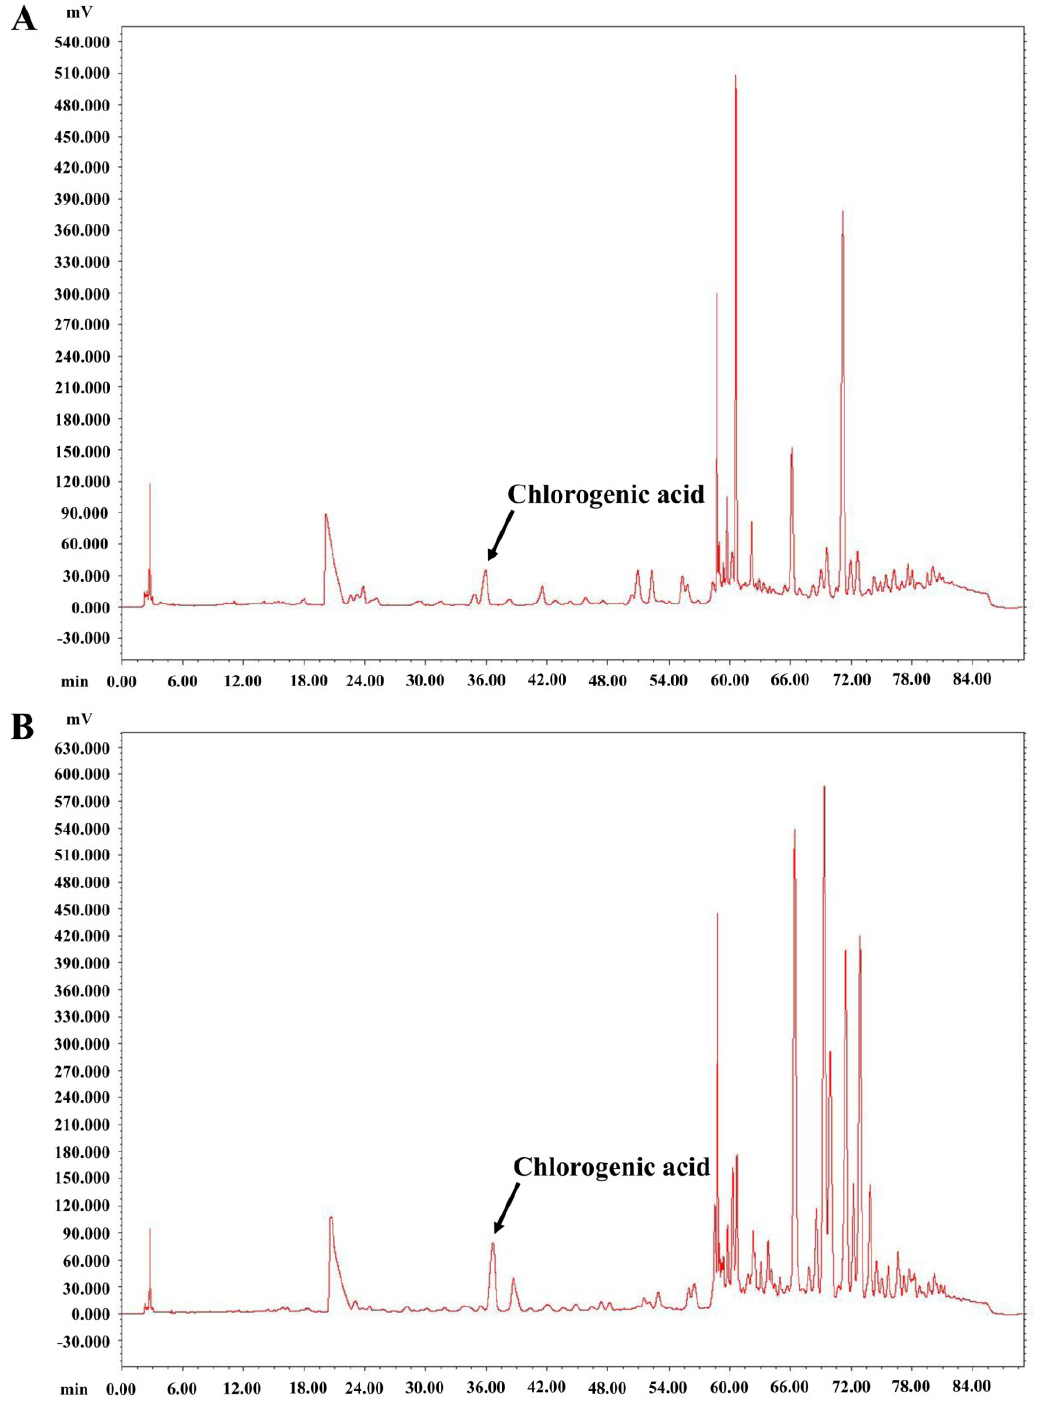
Figure 4. High-Performance Liquid Chromatography (HPLC) chromatograms of chlorogenic acid (CGA) analysis from control hairy roots ( A ) and OxPAP1-1 hairy roots ( B ) of P. grandiflorum